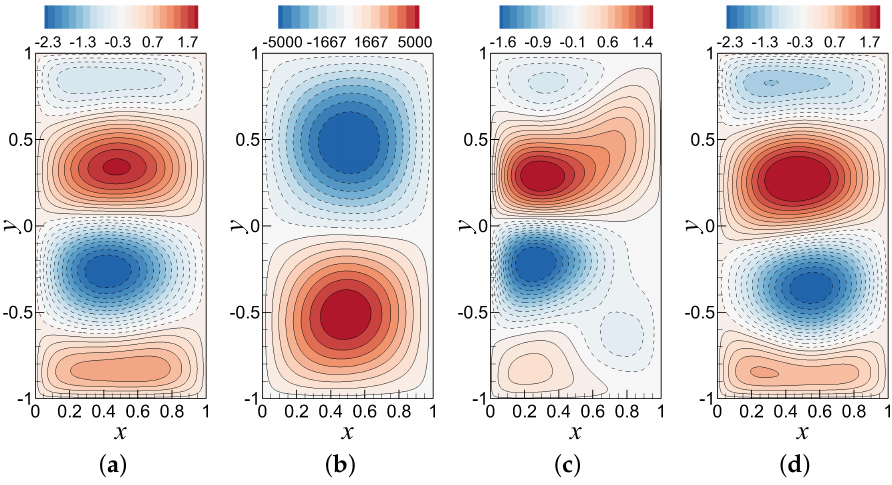
Figure 27. Out-of-sample forecast of mean stream function by: ( a ) FOM; ( b ) ROM-GP; ( c ) ROM-ANN; and ( d ) ROM-H using R = 10 POD modes. Predictive performance is shown for Re = 200 while the training has been performed using the data generated at Re = 400. Similar to the previous results, this figure also shows that the ROM-H prediction is better than the other two model